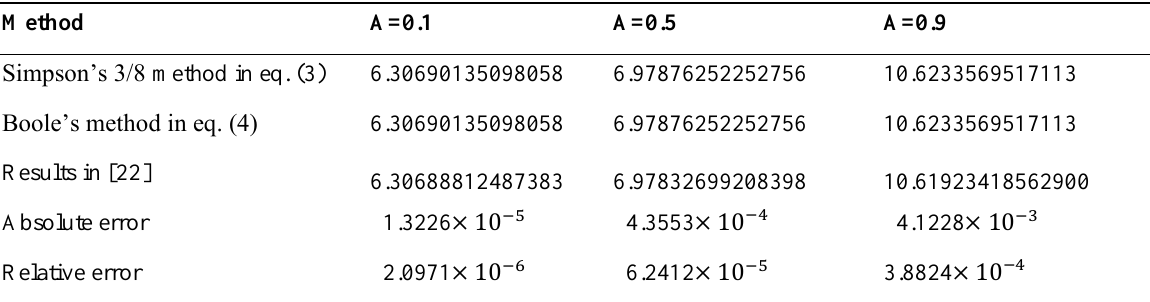
Table 3. Numerical quadrature method in (3) and (4) are compared with the exact solution in paper [22], in different values of A, where